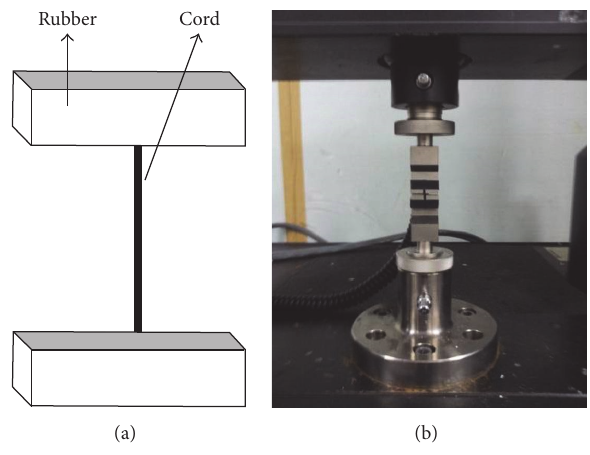
Figure 2: Preparation of the H-test: (a) the H-test sample; (b) photo of test set-up (ASTM